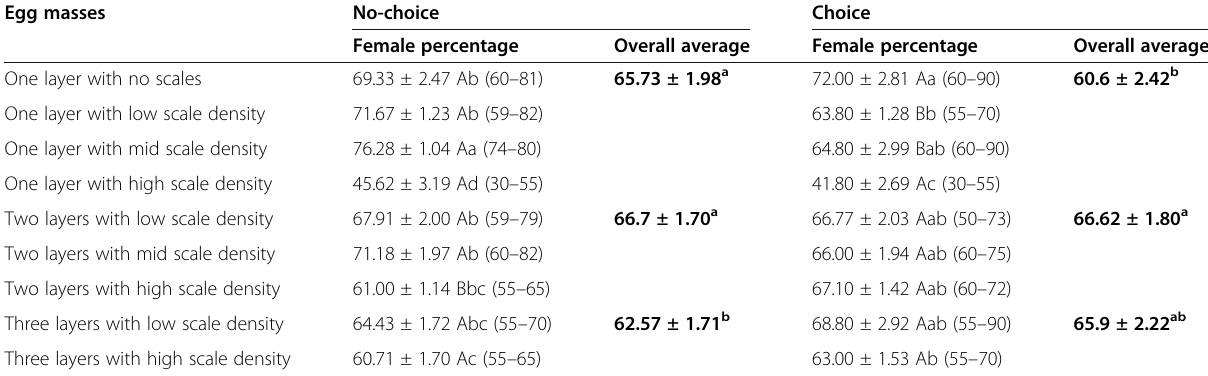
Table 3 Percentages of T. bactrae females emerged from S. littoralis egg masses with different physical characteristics in a no-choice and choice